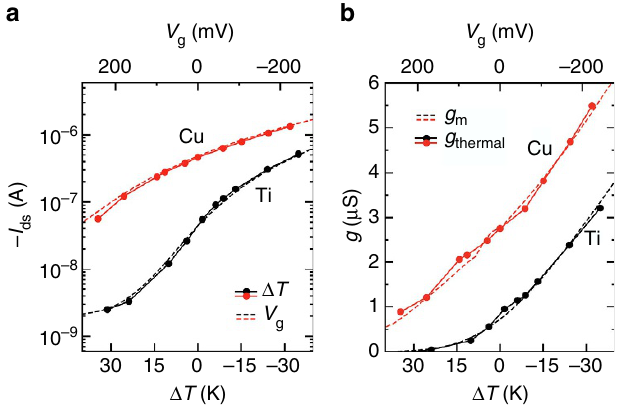
Figure 4 | Effect of gate metal electrode on heat-gated transistors. Comparison of the transfer characteristics of ionic thermoelectric-gated transistors comprising Ti and Cu as the gate electrode ( a ) and relative transconductance ( b ).